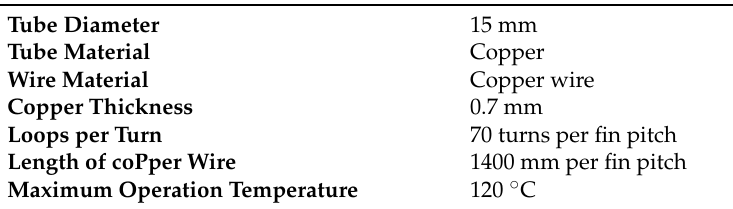
Table 1. Specification for the copper wire woven fins.